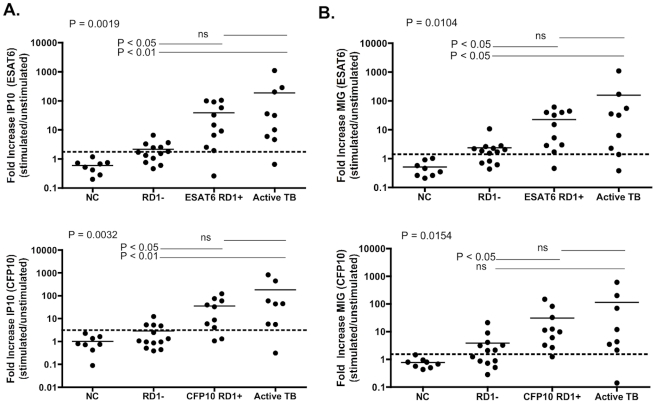
Mycobacterium tuberculosis infection as an example application.qPCR fold increase of IP10 (a) or MIG (b) in response to 8 µg/ml ESAT-6 or CFP-10 antigenic stimulation of 106 fresh PBMC for 16 hours. Patients are grouped according to RD1 Elispot status or culture confirmed active TB. NC (Negative Control)  =  HIV negative individuals who are RD1 Elispot negative and negative by PPD skin test, RD1−  =  HIV positive individuals who are RD1 Elispot negative with no symptoms of active TB, RD1+  =  HIV positive individuals who are RD1 Elispot positive with no symptoms of active TB. One-way ANOVA with Kruskal-Wallis test was p = 0.0019 for IP10/ESAT-6, p = 0.0032 for IP10/CFP-10, p = 0.0104 for MIG/ESAT-6, and p = 0.0154 for MIG/CFP-10. Dunn's Multiple comparison test was then performed. p<0.05 was considered significant. The Dunn's Multiple comparisons test showed a significant difference between RD1 negative and RD1+, and RD1 negative and active TB.